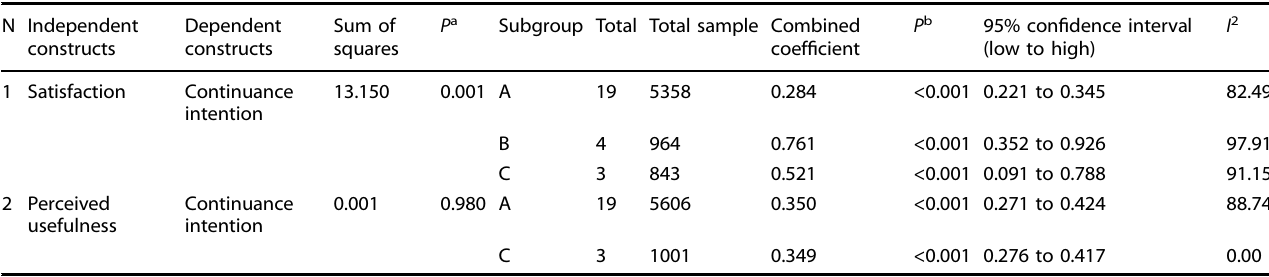
Table 5. Subgroup analysis by participants ’ age.